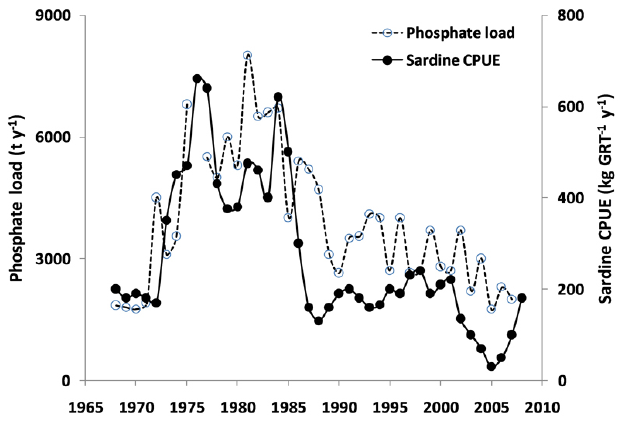
Fig. 4 . Relative abundance (CPUE, Catch Per Unit Effort) of sardine ( Sardina pilchardus ) in the Northern Adriatic